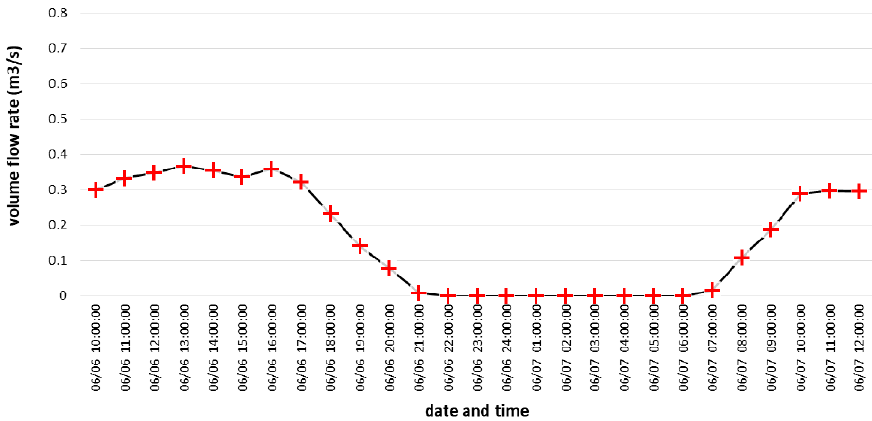
Figure 19. Simulated course of the volume flow rate through the tower into the attic. Table 9. Airflow characteristics through the openings at 6:00 a.m. obtained from BPS simulation.